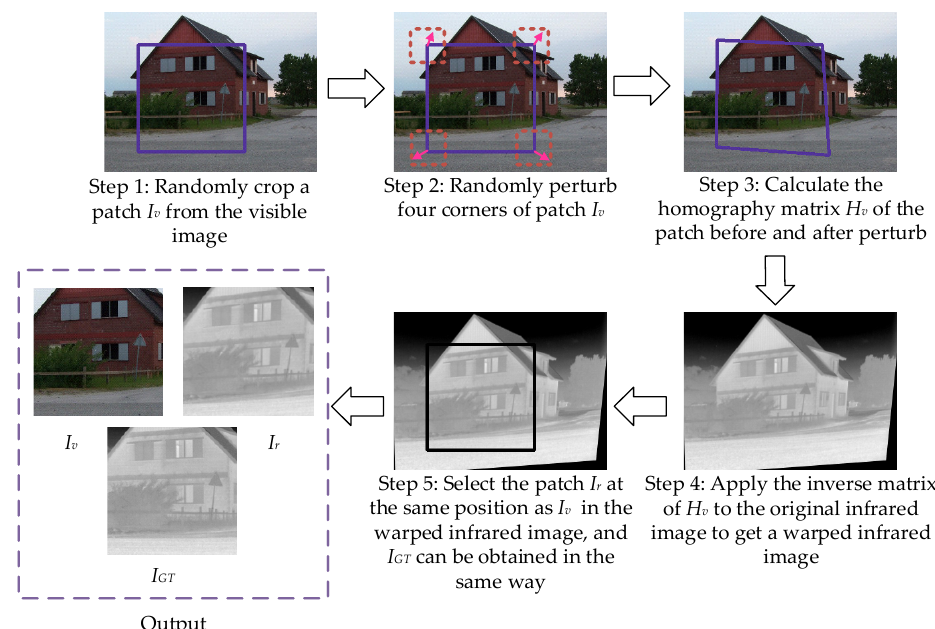
Figure 4. Production process of synthetic benchmark dataset.